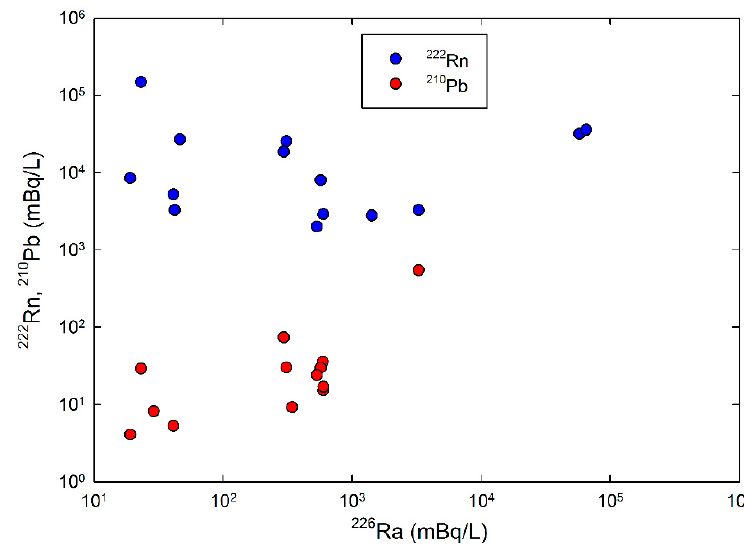
Figure 9. 226 Ra concentration vs. 222 Rn and 210 Pb concentrations.